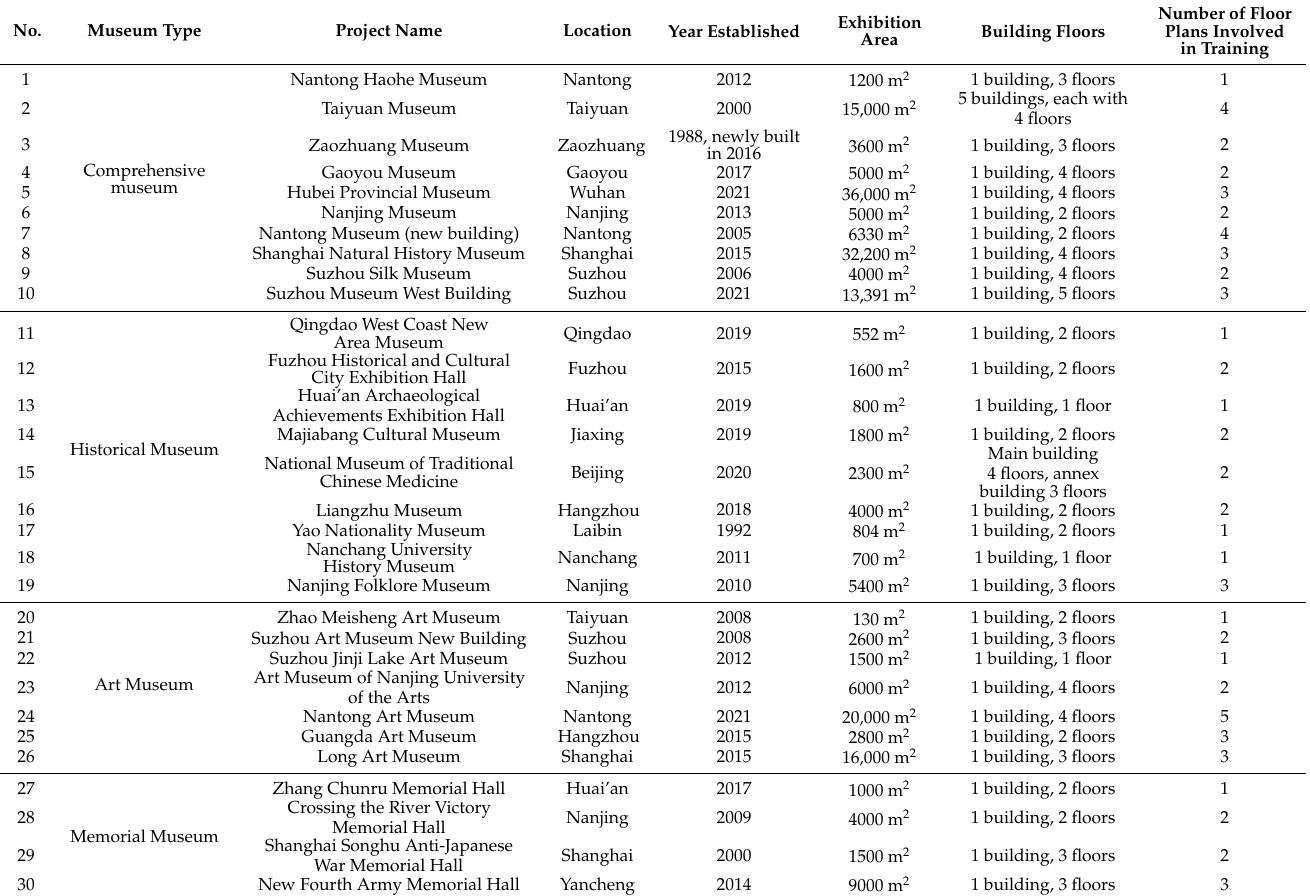
Table 1. Research materials (museum floor plan) and exhibition hall